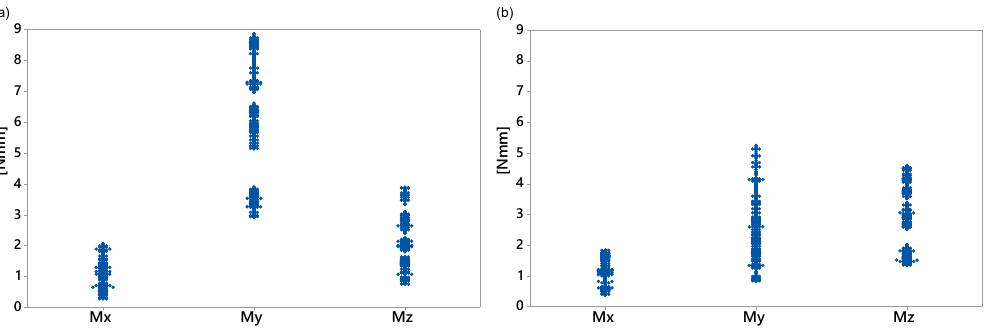
Figure 12. Maximum moments transmitted to housing by gasket: ( a ) middle load; ( b ) counter load.